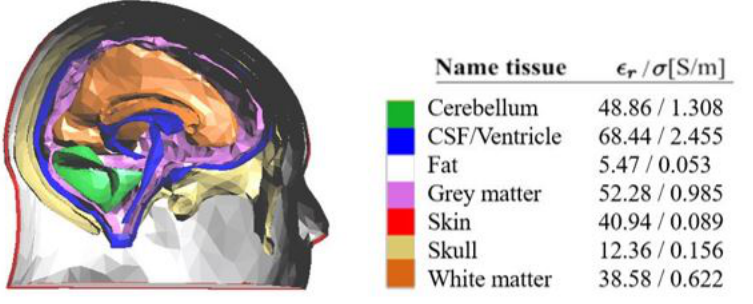
Figure 2. Left: sagittal cut of the used 3D multi-tissue head phantom; right: dielectric properties of all the head tissues at